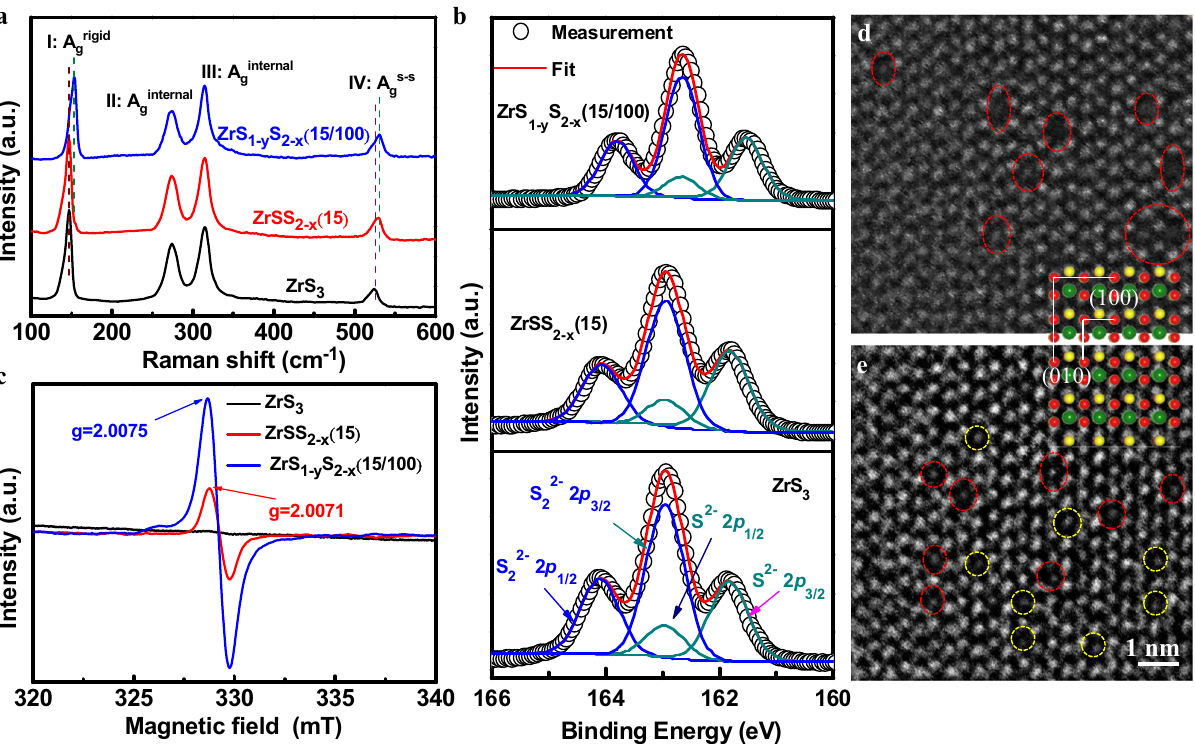
Fig. 3 Characterizations of vacancy structure of defective ZrS 3 NBs. a Raman spectra, b S 2 p XPS spectra, and c EPR spectra of the ZrS 3 , ZrSS 2-x (15) and ZrS 1-y S 2-x (15/100) NBs. HAADF-STEM images of d ZrSS 2-x (15) and e ZrS 1-y S 2-x (15/100) measured from a spherical aberration-corrected TEM. Inset: the crystal lattice of ZrS 3 along the [001] orientation. The red and yellow circles represent S 2 2 − and S 2 − ,